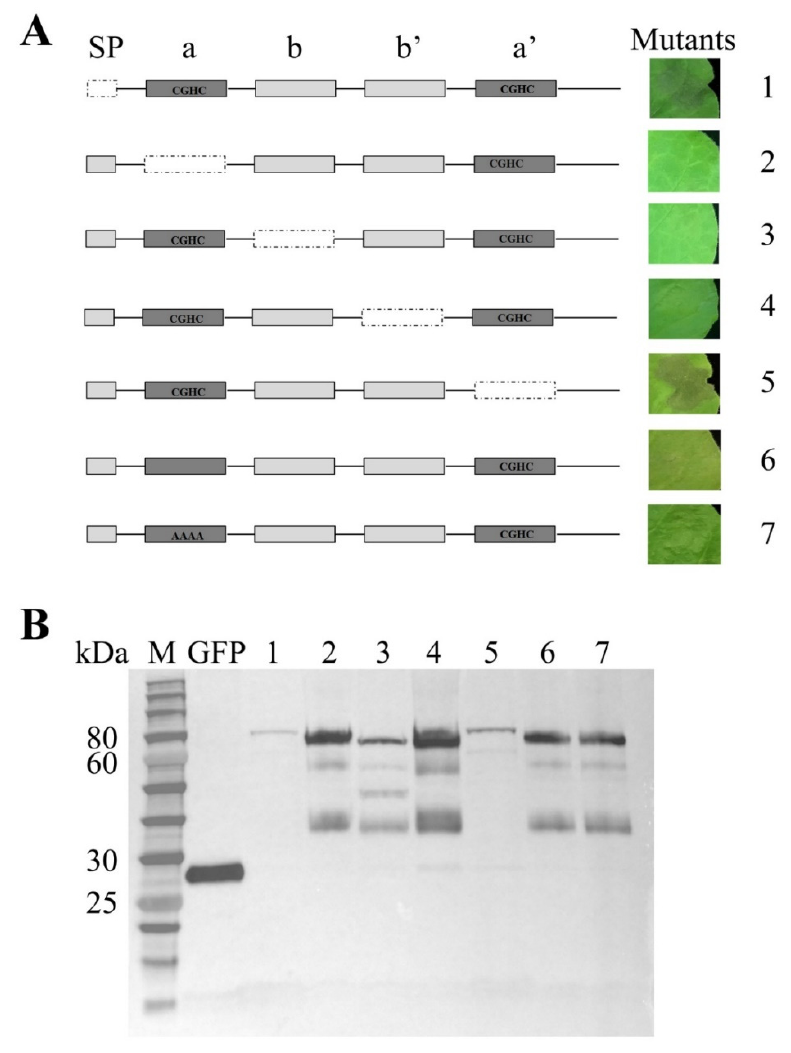
Figure 8. Determination of MgPDI2 domains required for cell death induction. ( A ) Schematic views of MgPDI2 and deletion mutants are shown on the left. The deletion mutants of MgPDI2 were transiently expressed in N. benthamiana leaves. ( B ) Western blot analysis of the MgPDI2 deletion series. The anti-GFP primary antibody was used to detect the accumulation of fused proteins in the leaves of N. benthamiana plants. 1: signal peptide deletion mutant; 2: “a” deletion mutant; 3: “b” deletion mutant; 4: “b (cid:48) ” deletion mutant; 5: “a (cid:48) ” deletion mutant; 6: CGHC in domain “a” deletion mutant; 7: CGHC in domain “a” replaced by AAAA mutant. The ladder used as size standards for the gel consists of the following molecular weight bands: 250, 150, 100, 80, 60, 50, 40, 30, 25, 20, 15, and 10 kDa. The presence of numerous bands might be due to the poor antibody